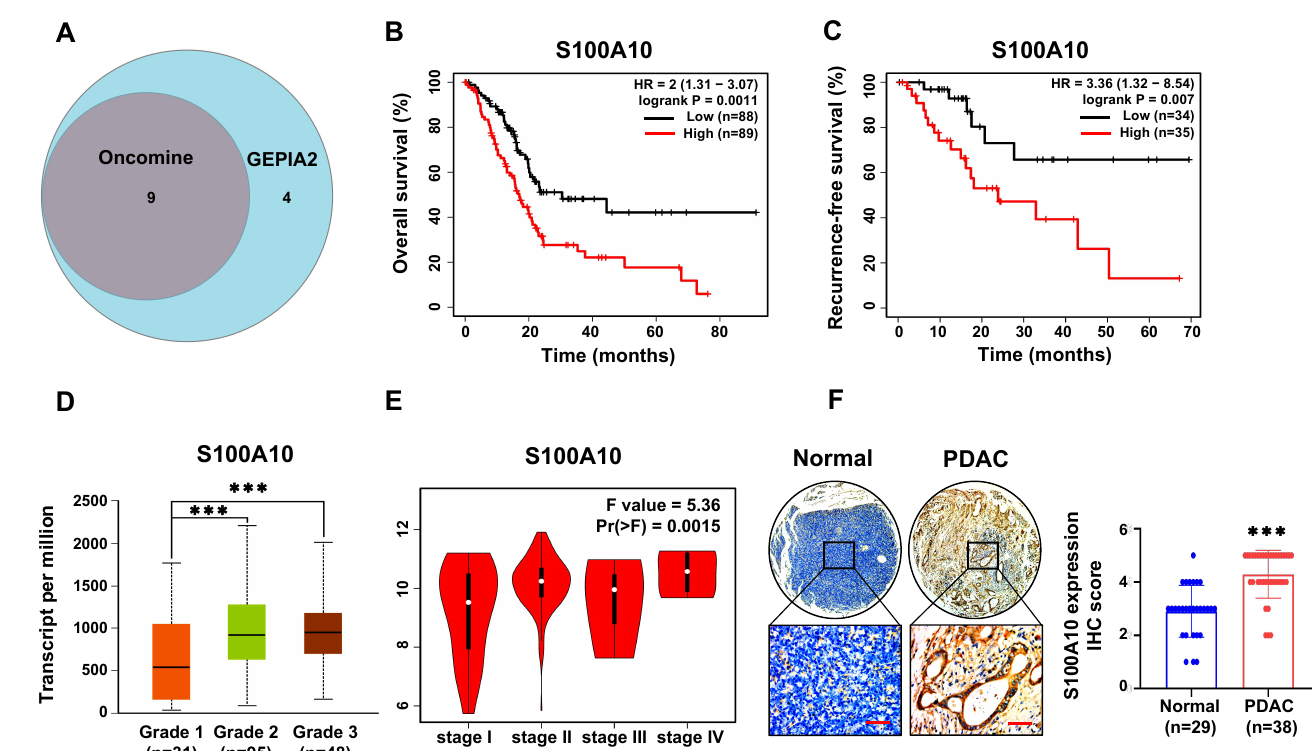
Figure 1. S100A10 is up-regulated in PDAC tissues and associated with an unfavorable prognosis by integrated bioinformatics and human PDAC samples analyses. ( A ) The intersection of the significantly up-regulated S100s members analyzed in Oncomine database and GEPIA database. ( B , C ) The overall survival and recurrence-free survival analyses for S100A10 in PDAC patients in Kaplan–Meier Plotter database (cutoff of logrank p -value: 0.05). ( D , E ) The correlation analyses between S100A10 and tumor grade/stage in PDAC patients in UALCAN database (grade: *** p < 0.001 by Student’s t -test; stage: p < 0.05 by F-test). ( F ) IHC staining of S100A10 in PDAC tissues and pancreatic non-tumor tissues (*** p < 0.001 by Mann–Whitney test). Scale bar: 50